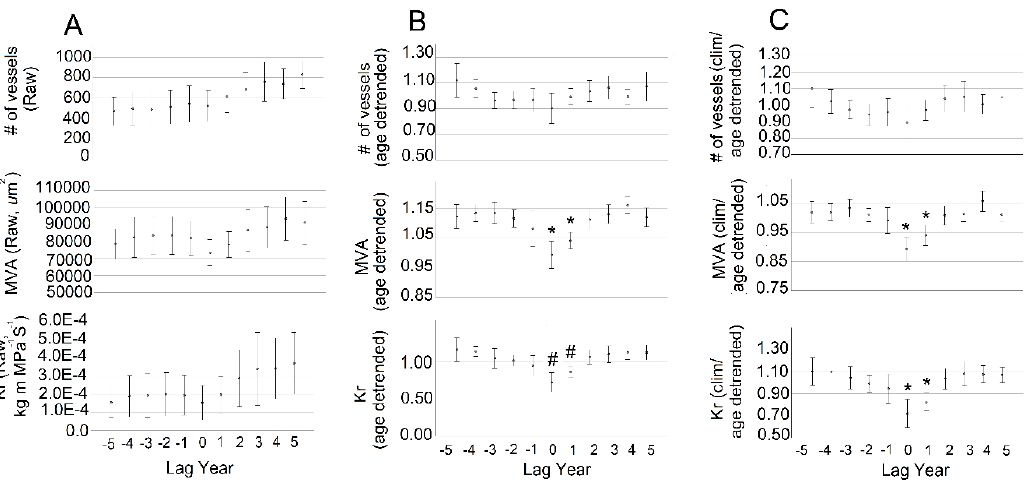
Figure 3. 95% confidence intervals for time-series of the 14 cross-sections showing the average of number of vessels, mean vessel area (MVA), and potential hydraulic conductivity (Kr), respectively for each year under the 11-year time-series which includes the fire scar year (lag0) at the center. ( A ) 95% confidence intervals for raw time-series: No significant differences were found in any time course according to one-way ANOVA. ( B ) 95% confidence intervals for age-detrended time-series: For MVA and Kr, the scar year and one-year post-fire had significantly decreased values ( p < 0.001, signified by “*”) compared to all other years according to one-way ANOVA and Tukey posthoc comparisons, Kr for lag0 and lag1 were marginal decreases ( p = 0.071, 0.086, respectively, signified by “#”). No significant differences were found for the number of vessels between the years of analysis. ( C ) 95% confidence intervals for the age- and climate-detrended time-series: For MVA and Kr, lag0 and lag1 had significantly decreased values ( p < 0.001) compared to all other years according to one-way ANOVAs and Tukey posthoc comparisons. No significant differences were found for the number of vessels between the years of analysis.